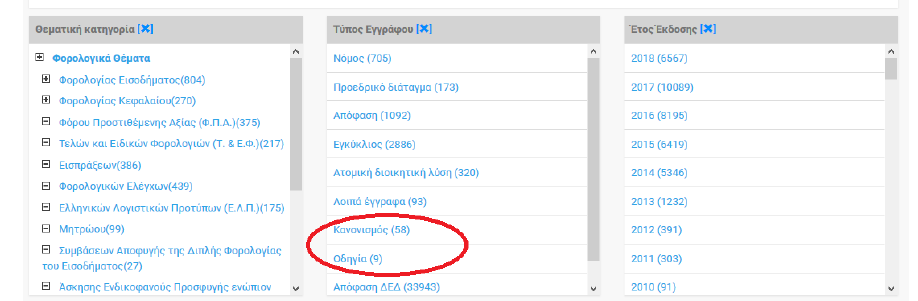
Figure 11. Basic navigation facets. Numbers in parenthesis denote the number of legal documents having that feature. The (red) circle highlights Regulations and Directives from the European Parliament and the Council (In Greek).